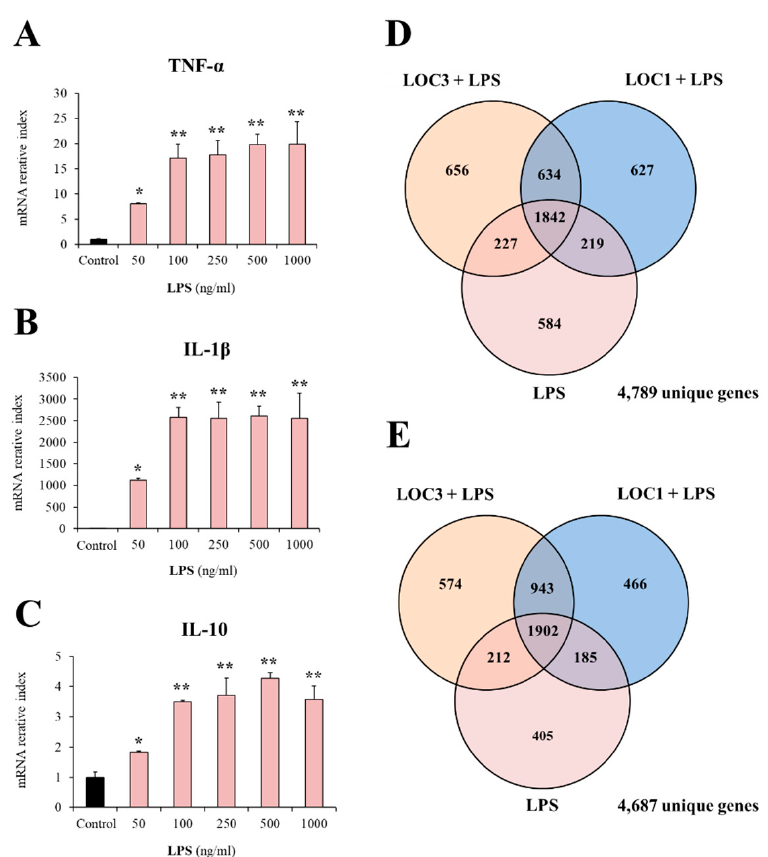
Figure 1. Effect of Lactiplantibacillus plantarum strains isolated from fresh tea leaves in murine RAW macrophages stimulated with the Toll-like receptor 4 (TLR4) agonist lipopolysaccharide (LPS). The expression of the immune factors TNF- α ( A ), IL- β ( B ) and IL-10 ( C ) was determined 3 h after different doses of LPS stimulation. Asterisks indicate significant differences between the indicated groups and control macrophages, (*) p < 0.05, (**) p < 0.01. Macrophages were treated with L. plantarum LOC1 or LOC3 strains and then challenged with LPS. The expression of genes was determined by microarray analysis 3 h after LPS stimulation. Non-lactobacilli-treated macrophages stimulated with LPS were used as control. Venn diagrams showing the number of differentially up-regulated ( D ) and down-regulated ( E ) genes for each experimental group.